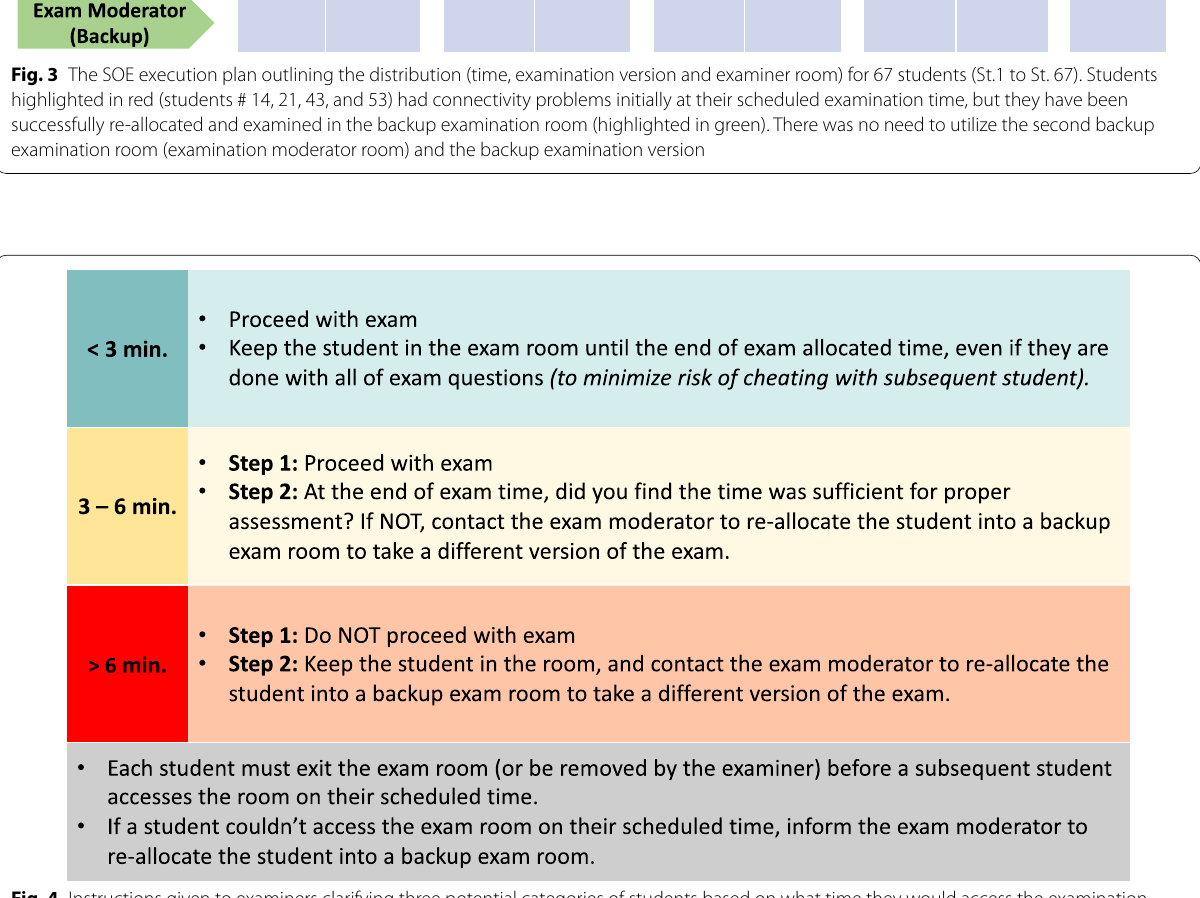
Fig. 4 Instructions given to examiners clarifying three potential categories of students based on what time they would access the examination room and what actions should be taken. Appropriate action for students who could not access the examination rooms on their scheduled time is also